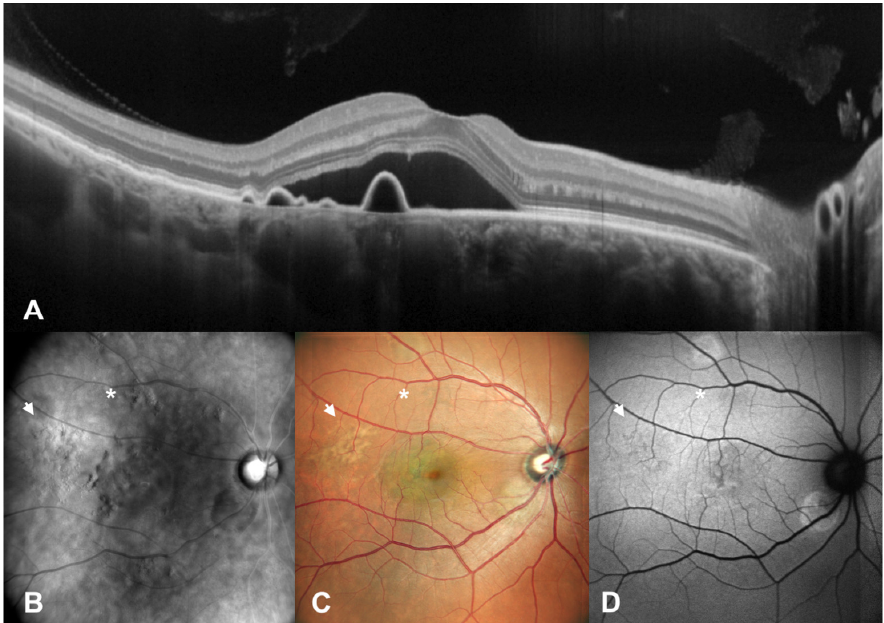
Figure 2. Patient with central serous chorioretinopathy assesed by multimodal imaging (II). A patient with central serous chorioretinopathy is assesed by spectral domain optical coherence tomography (SD-OCT) ( A ), scanning laser ophthalmoscopy (SLO) retromode imaging ( B ), SLO color fundus imaging ( C ) and fundus autofluorescence (FAF) ( D ). In this case, we have the presence of RPE mottling (arrows and asterisks, highlighting RPE abnormalities on fundus images), which is detectable with SLO retromode imaging, while eliciting only mild hypo-autofluorescence in FAF.